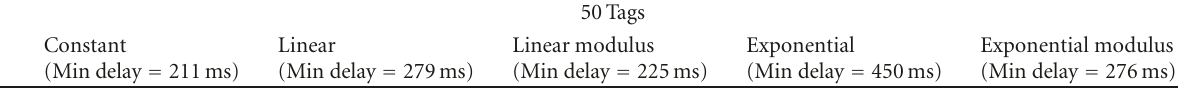
Table 4: The ICW and the coe ffi cient values, C , L , and E , giving lowest energy consumption (Energy) when choosing a specific delay, 50tags, and the di ff erent algorithms.